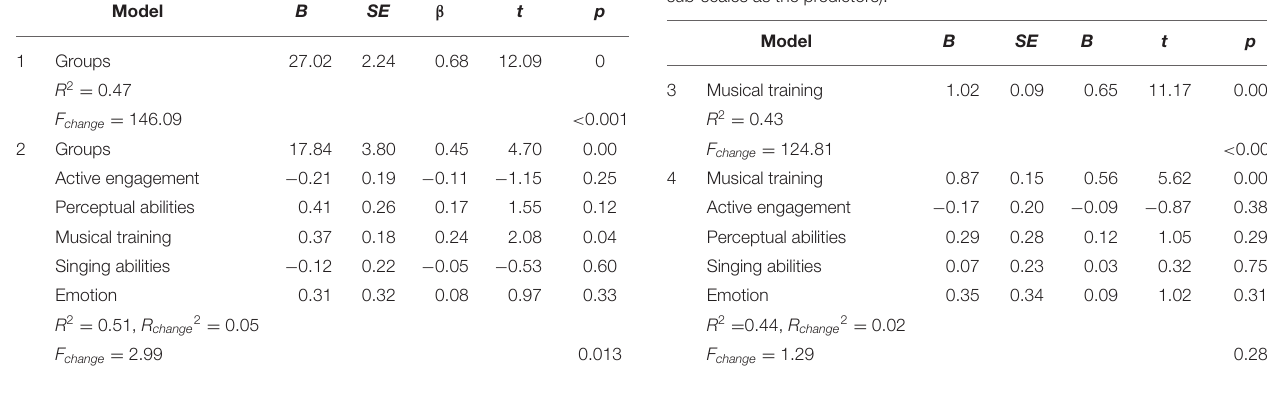
TABLE 5 | Multiple linear regressions for accuracy of tone identification in Model 3 (musical training as the predictor) and Model 4 (musical training + four other sub-scales as the